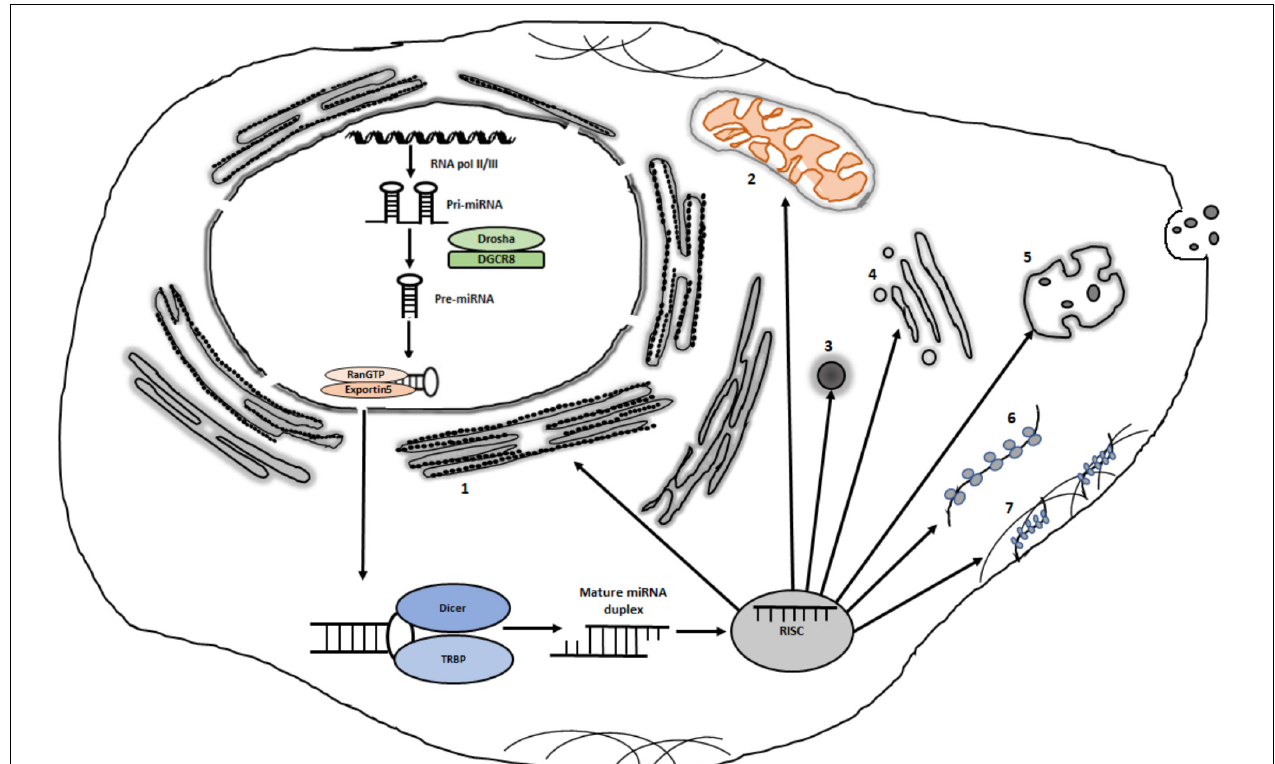
FIGURE 1 | Potential intracytoplasmic destinations of miRISCs. Following transcription and processing in the nucleus, some miRISCs are destined for the nucleus (not shown). Cytoplasmically localized miRISCs can be localized in distinct sites such as: (1) rough endoplasmic reticulum; (2) mitochondria; (3) various types of messenger ribonucleoprotein granules such as P bodies and stress granules; (4) golgi; (5) multivesicular bodies; (6) free polysomes and (7) cytoskeleton-bound polysomes. Organelles and complexes are not drawn to scale.